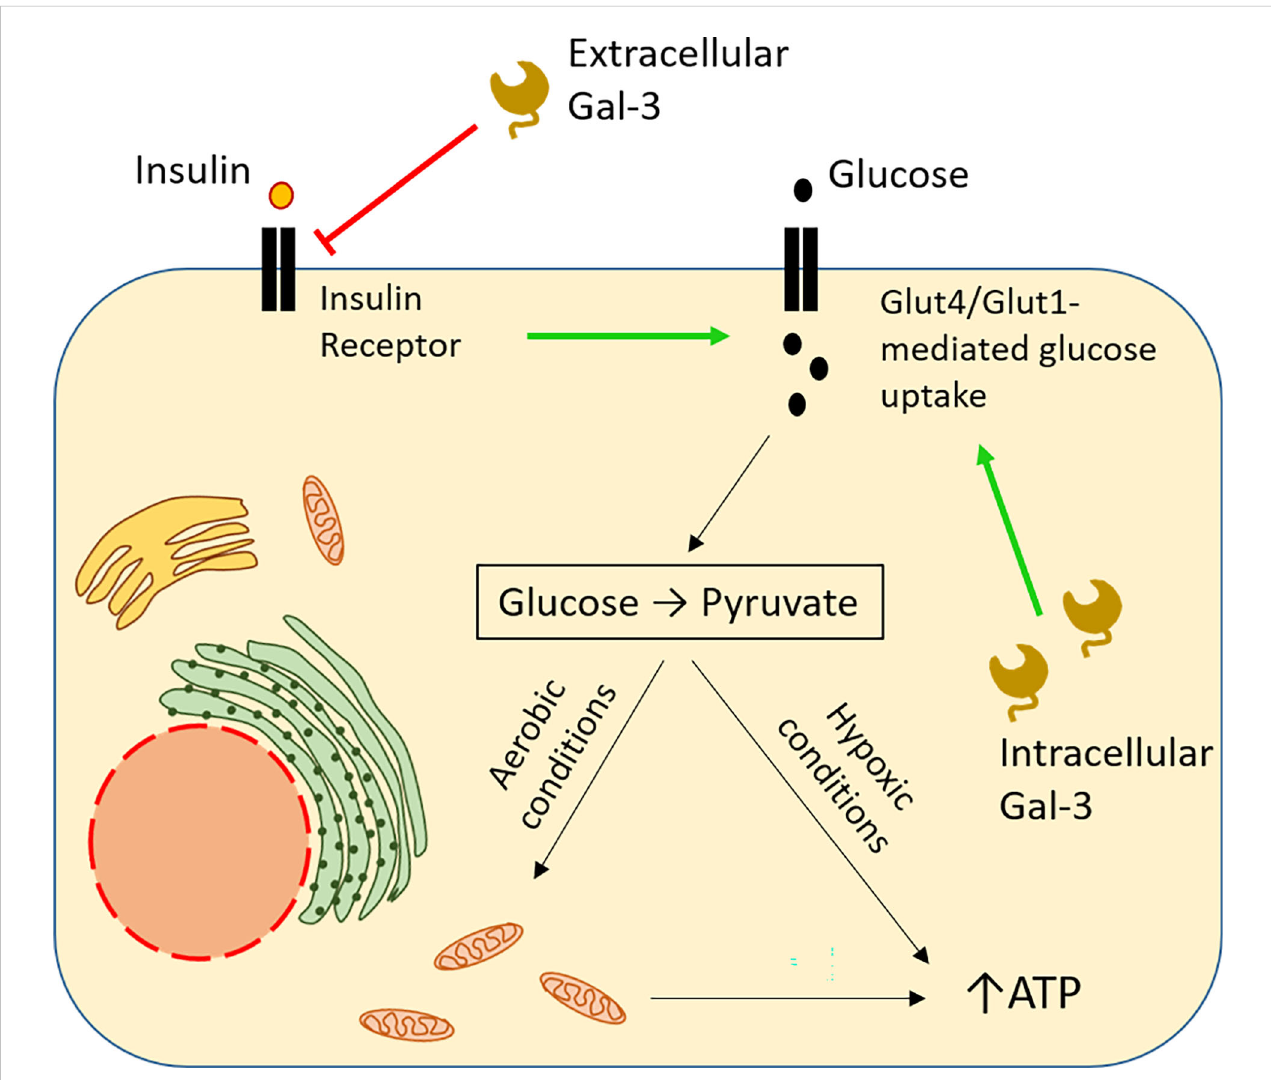
FIGURE 3 Opposite impact of intracellular and extracellular Gal-3 on glucose uptake. Intracellular Gal-3 mimics insulin binding to its receptor, sustaining expression of the GLUT family of membrane transporters, thus leading to increased glucose uptake by the cell (61, 89 ). In the cytoplasm, glucose is broken down to pyruvate, producing ATP. Under adequate levels of oxygen, pyruvate enters mitochondria, triggering the cell respiration cycle, resulting in more robust ATP synthesis, securing high energy levels for the cell. In contrast, extracellular Gal-3 blocks glucose uptake by the cell, functioning as an antagonist of insulin and preventing binding of the latter to its receptor (91). Hypoxia frequently occurs in the tumour microenvironment forcing the cells to switch to anaerobic glycolysis whose ATP yield is low. Therefore, the needs of external glucose are strongly enhanced in malignant and nearby non- malignant cells. High production of Gal-3 endows the malignant cells with a double selective advantage. Glucose intake is enhanced by internal Gal-3 in malignant cells while it is reduced in non-malignant cells by secreted external